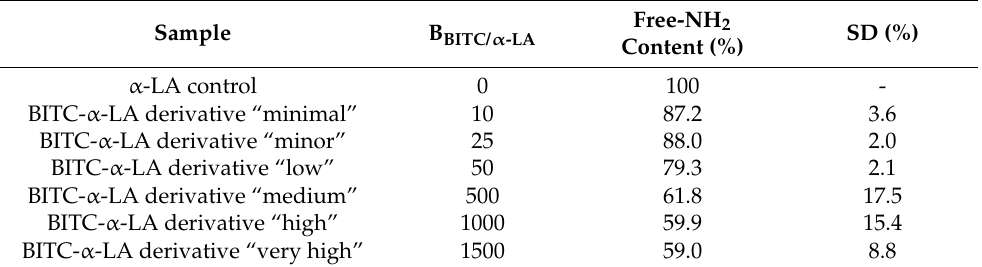
Table 1. Free amino group content of the unmodified α -LA and BITC- α -LA